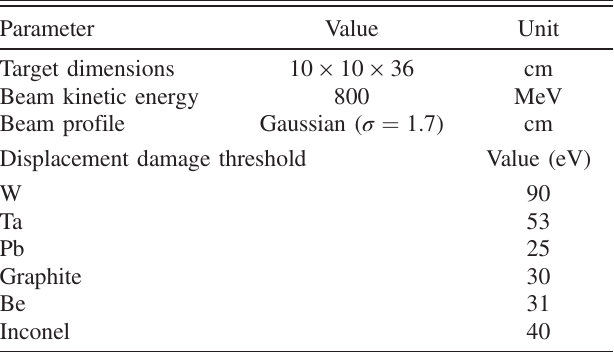
TABLE IV. Simulation parameters of the radiation damage case.